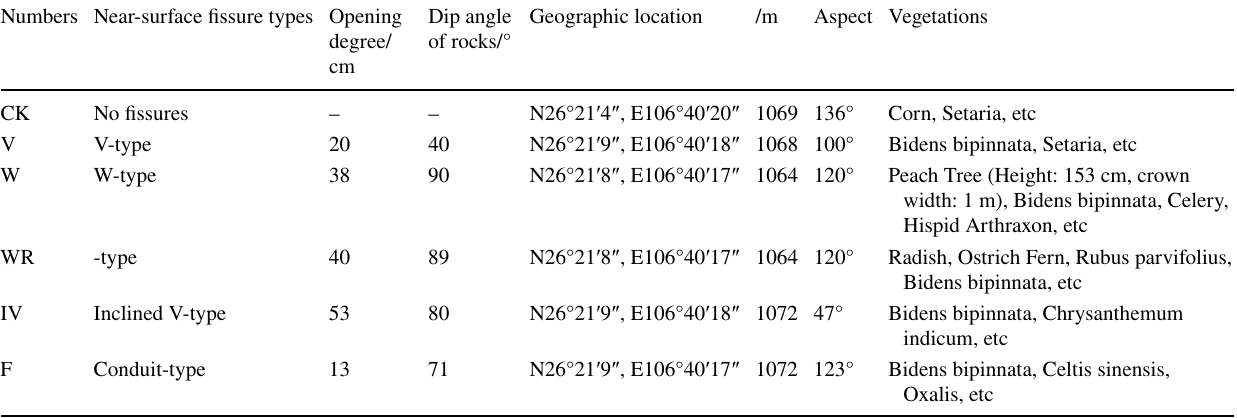
Table 1 Basic information of the selected of near-surface fissures Numbers Near-surface fissure types Opening